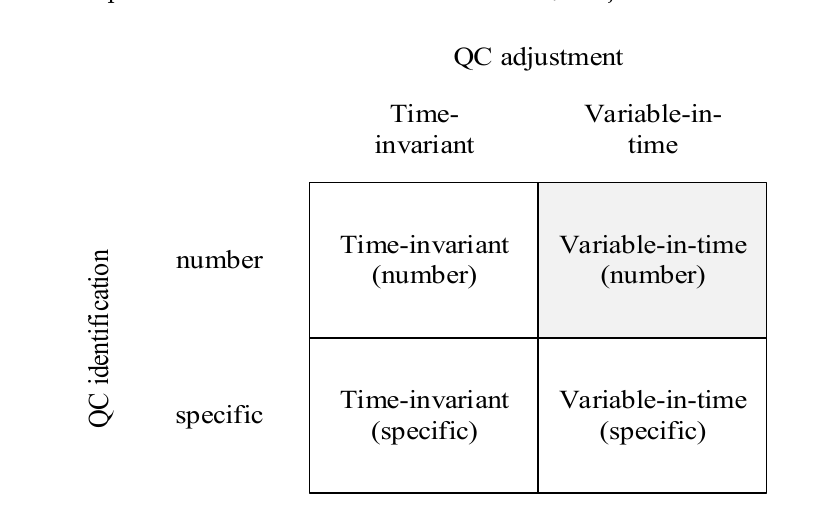
Figure 2. The quay crane assignment problem (QCAP) variants.